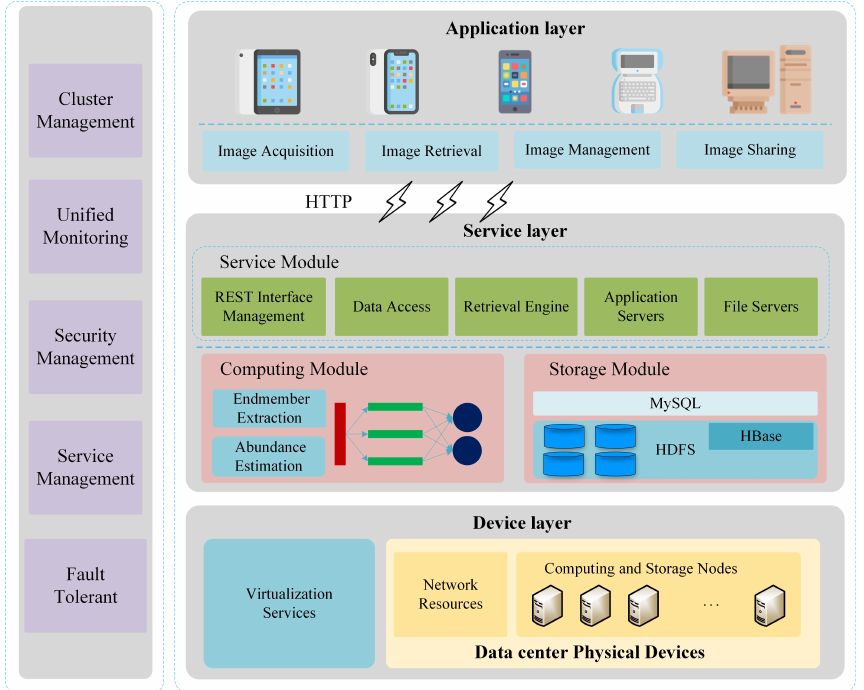
Figure 1. The cloud-computing-based content-based image retrieval (CBIR) architecture in SaaS mode for hyperspectral image (HSI)